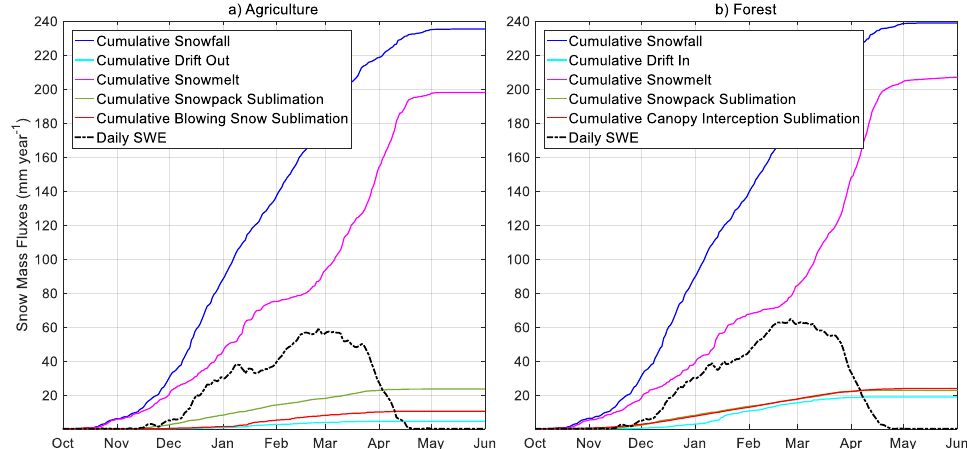
Figure 5. Average simulated cumulative snow mass fluxes and daily SWE between the years 1996 and 2019 in ( a ) agriculture ( b ) forest. 2019 in ( a ) agriculture ( b )